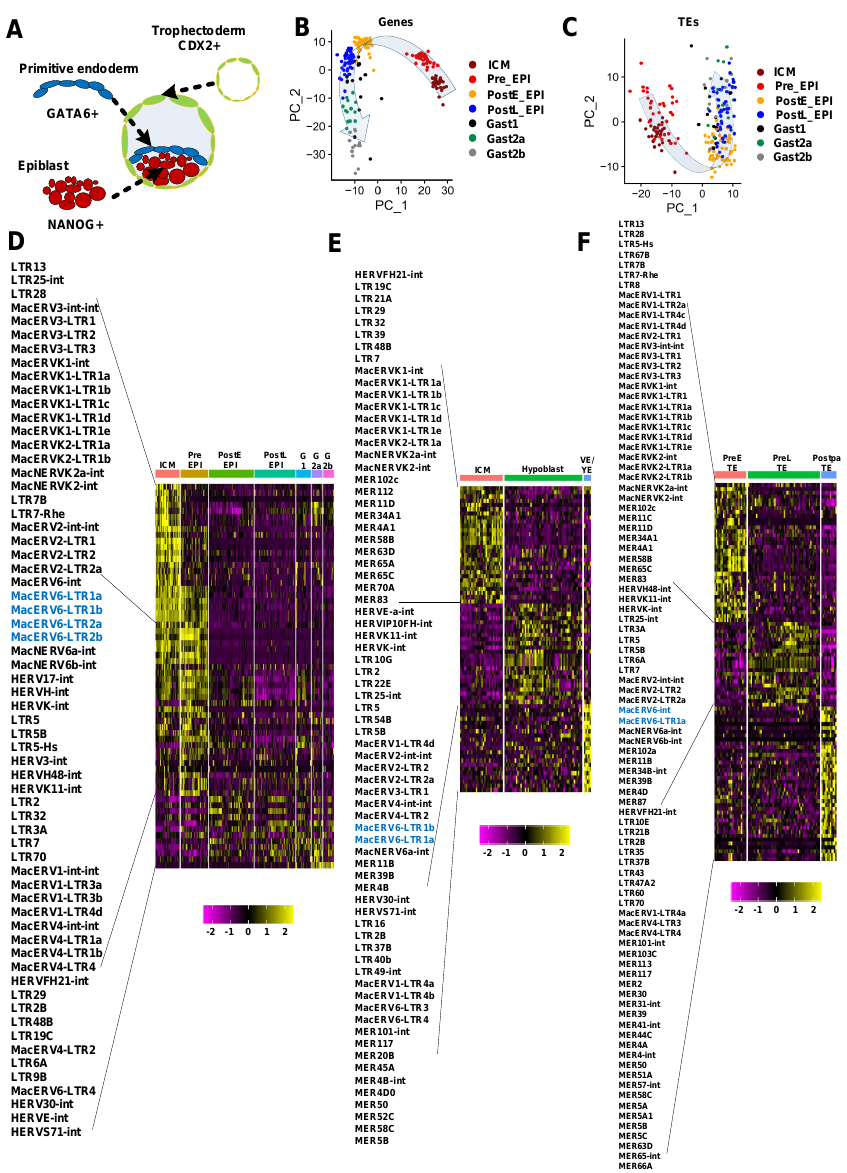
Figure 1. The dynamic expression of LTR elements during the development of Macaca fascicularis embryo from blastocysts to the E17 gastrulation stage. ( A ) Schematic view of three lineages of Macaca fascicularis blastocyst. ( B ) Principal component analysis with gene expression levels during Macaca fascicularis epiblast development with Seurat. ( C ) Principal component analysis with expression levels of transposable element (TEs) during Macaca fascicularis epiblast development. ( D ) Heatmap of LTR elements expression during epiblast development. The cell type include inner cell mass (ICM) ( n = 30), pre-implantation epiblasts (PreEPI) ( n = 34), post-implantation early EPI (PostEEPI) ( n = 55), post-implantation late EPI (postLEPI) ( n = 50), gastrulating cells (G1) ( n = 18), (G2a) ( n = 13), and (G2b) ( n = 13) stages. ( E ) Heatmap of LTR elements exoression during primitive endoderm development. The cell type include inner cell mass (ICM) ( n = 30), Hypoblast (also named PrE) ( n = 54), visceral/yolk-sac endoderm (VE/YE) ( n = 5). ( F ) Heatmap of LTR elements expression during trophectoderm (TrB) development. The cell type include pre-implantation early trophectoderm (PreETE) ( n = 23), pre-implantation late TE (PreLTE) ( n = 52), post-implantation parietal trophectoderm (PostpaTE) ( n =